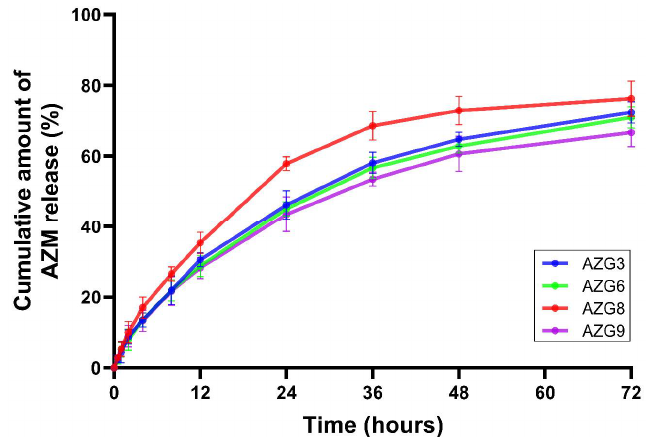
Figure 4. Percent cumulative drug release of AZG formulations. Data are mean ± SD, n = 3. The cumulative drug release data were analyzed with various kinetic models, such as the zero- order, first-order, Higuchi, and Korsmeyer–Peppas models. The results of linear regression with the equation parameters of each formulation are displayed in Table 4. The AZG formulation release rates were best fitted to the Korsmeyer–Peppas model, which indicated that the AZG formulation drug release was provided by polymeric matrix drug delivery [46]. When considering the release exponent (n) of the Korsmeyer–Peppas equation, the n-values were in the range of 0.45 < n < 0.89 [47]. Therefore, the drug is released in a non-Fickian diffusion manner. AZM formulation release was from both polymeric matrix diffusion and erosion [48]. The physical properties of AZG played an important role in the release behavior. AZG8, which yielded the highest release rate, consisted of 18% P407 and 1.1% HA. Decreased concentrations of P407 and HA resulted in lower hardness in the tested group. Consequently, the AZG8 gel matrix easily eroded, allowing faster drug release. A similar explanation could be applied to the releases of AZG3, 6, and 9. These formulations were equally composed of 2% HA, and the hardness of the gel matrices was solely dependent on the concentrations of P407. AZG3, with 17% P407, had the lowest gel hardness compared with AZG6 (18% of P407) and 9 (19% of P407). Therefore, AZG3 exhibited the highest drug release rate, followed by AZG6 and 9. Table 4. Kinetic model fitting of AZG formulations.